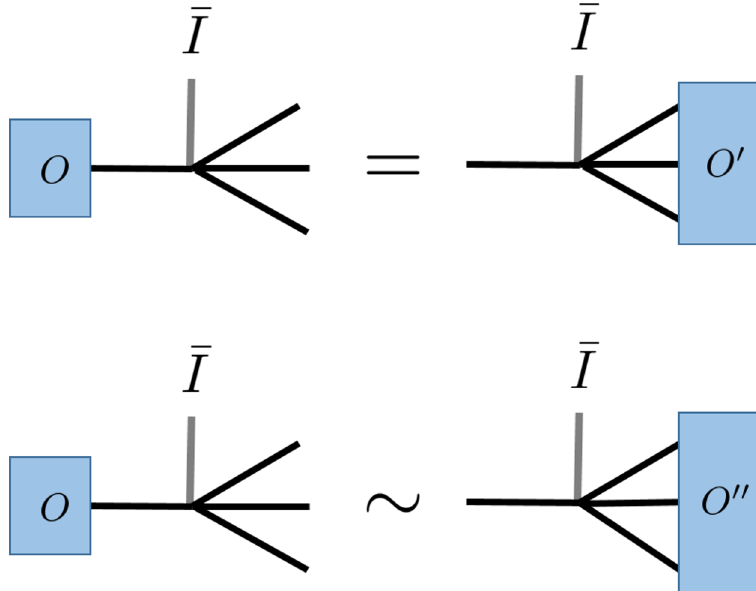
Figure 9. Top: pushing using stabilizers. Bottom: pushing using gauge operator. Note that the state in the top are precisely equal when we use stabilizers. The bottom will change the state from one member of the equivalence class to another while preserving the entanglement structure, as the gauge operators are transversal. Both pushing preserves the entanglement structure of the state. We do not leave the orbit where entanglement can change. This is important to note.